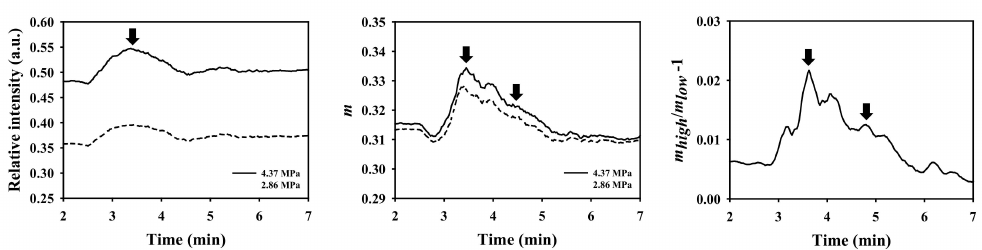
Figure 12. Typical ( a ) backscattered power, ( b ) WMC Nakagami parameter, and ( c ) WMC Nakagami parameter ratio as a function of time measured from the hindlimb GM of a rat. The black arrows indicated the peak concentrations corresponding to the first arrival and the first recirculation of administrated